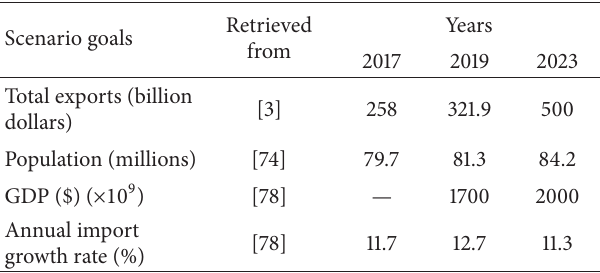
Table 4: Turkey’s 2023 growth goals and mid-year population esti-